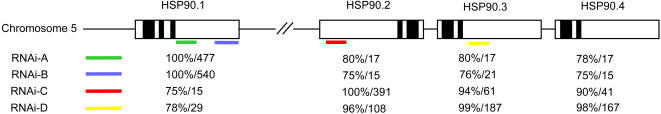
Targeting HSP90 with double-strand RNA constructs.The four cytosolic HSP90s are depicted in their genomic context. Introns are in black, exons in white. Regions cloned to create the double-strand RNA (RNAi) constructs are indicated in green (RNAi-A), blue (RNAi-B), red (RNAi-C), and yellow (RNAi-D) bars. Below each isoform the percent identity and the longest consecutive number of bases of perfect identity to the cloned region are noted for each construct.